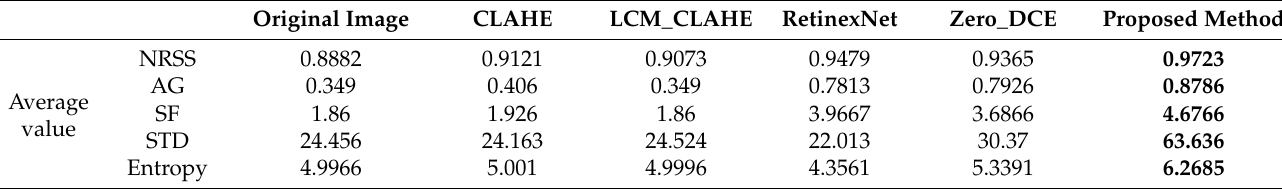
Table 3. Evaluation indicators of different methods.